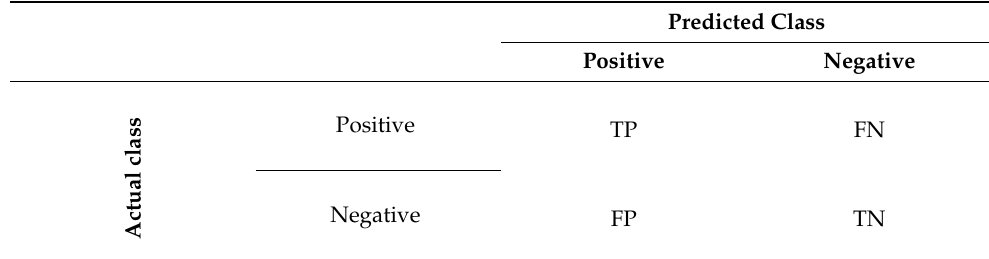
Table 2. Confusion matrix table layout .